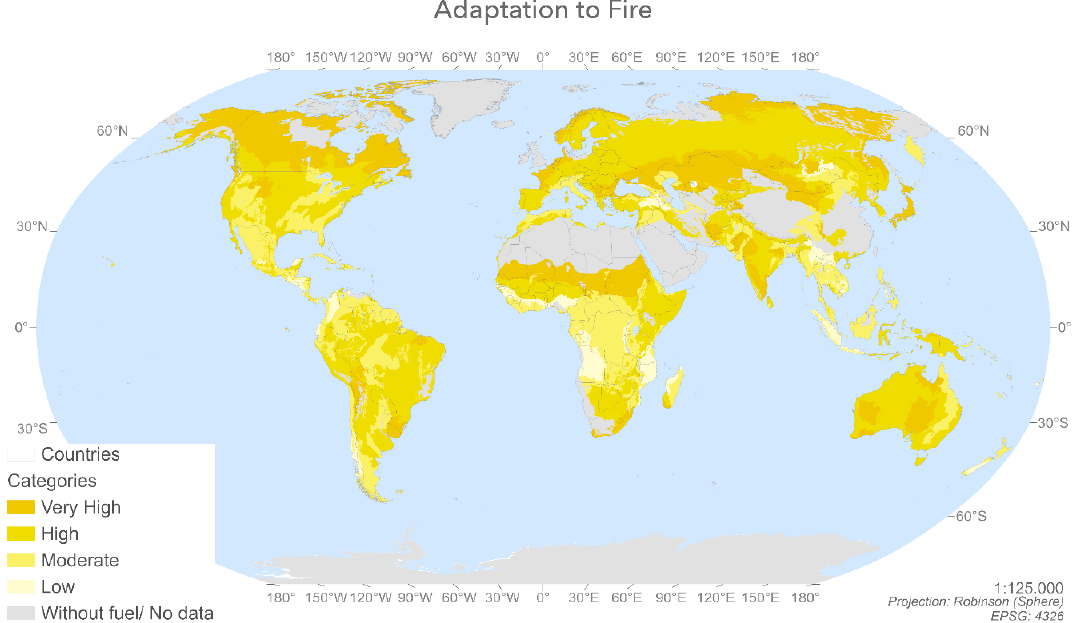
Figure A4. Spatial distribution by ecoregion of the ecosystem adaptation to fire value produced by combining the fire regime and its degree of alteration (source: the authors).